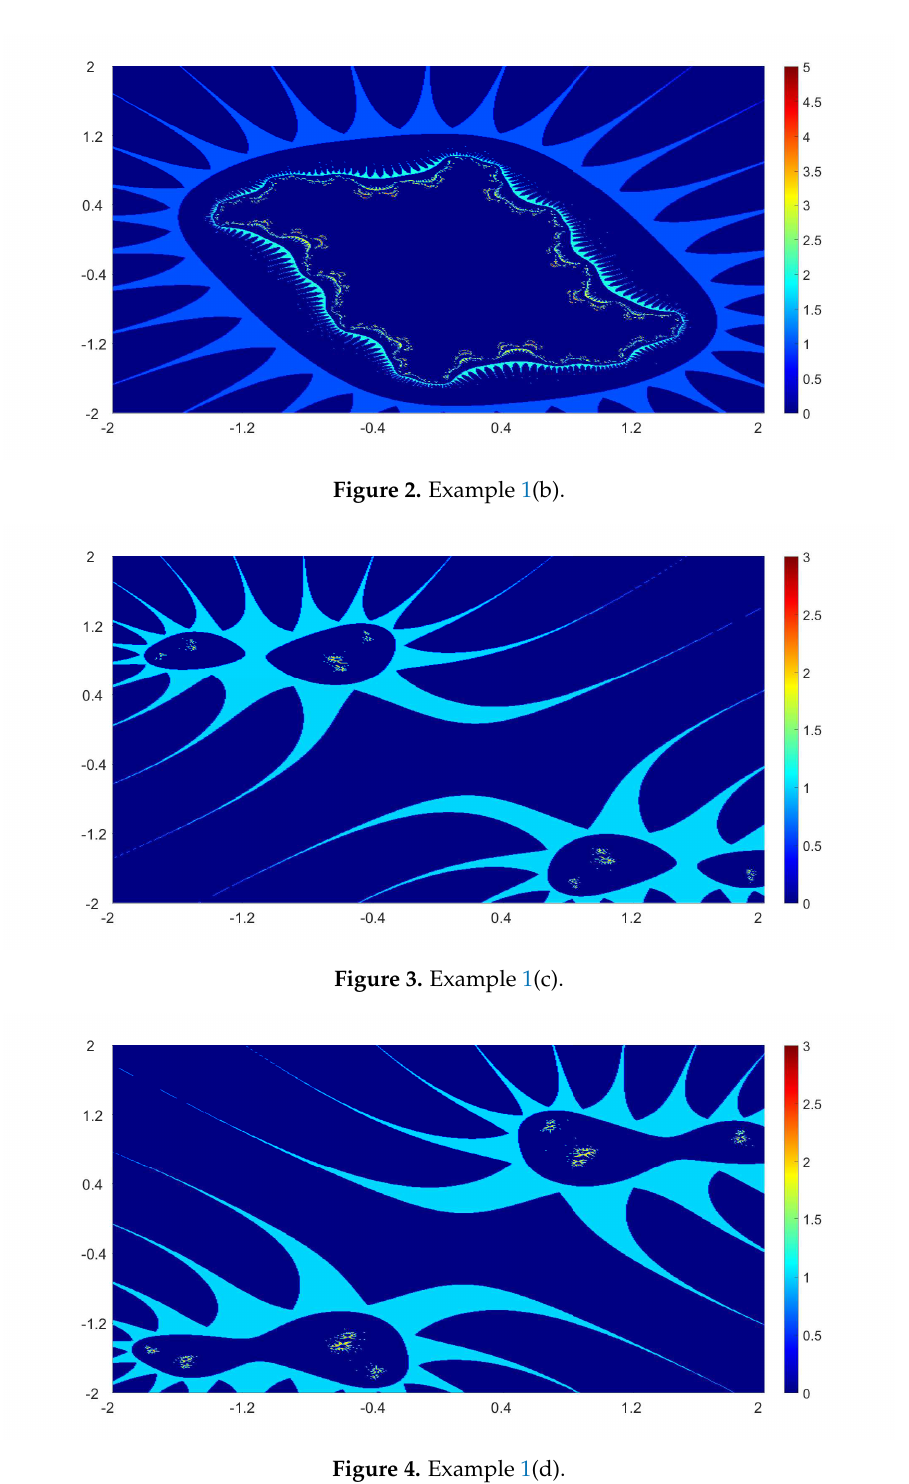
Figure 4. Example